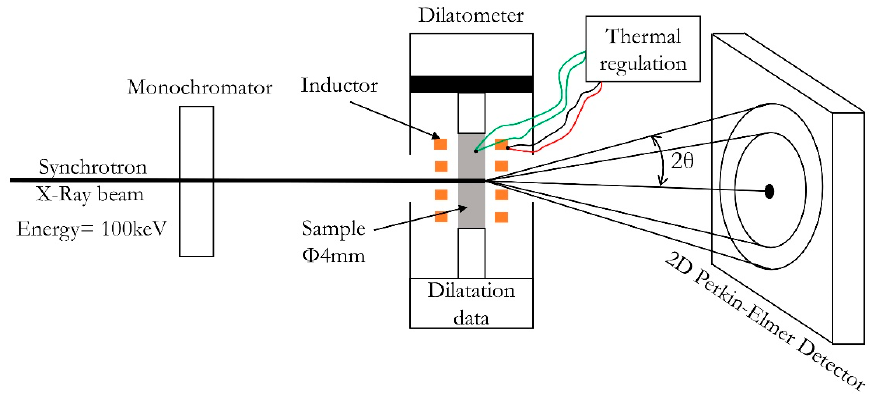
Figure 1. Schematic representation of the experimental setup as used at the Deutsches Elektronen-Synchrotron (DESY) beamline P07.